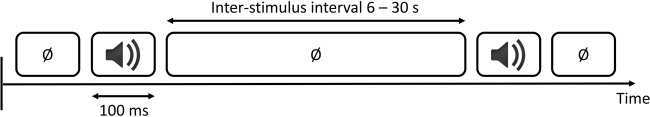
Single-stimulus paradigm using ignored and infrequent auditory probes.